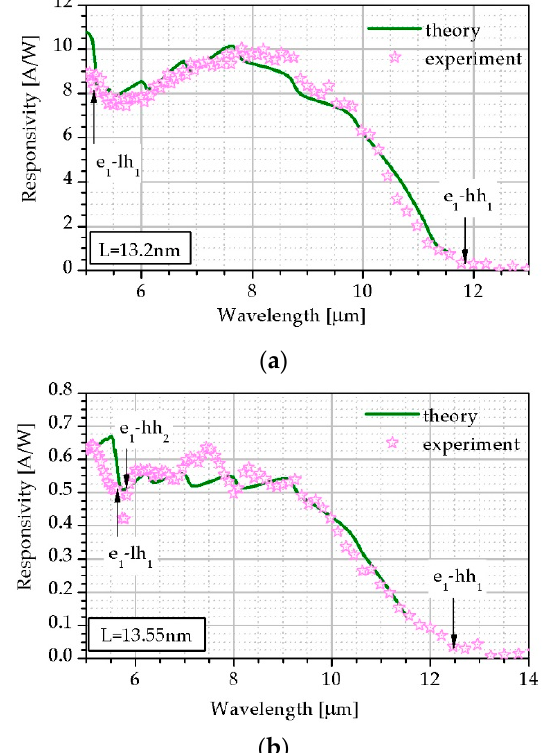
Figure 10. R i theoretical simulation and experimental results for T2SLs InAs/InAs 0.62 Sb 0.38 photoconductor for ( a ) sample-A; ( b ) sample-B at T = 230 K. Table 3. The sample-A and sample-B